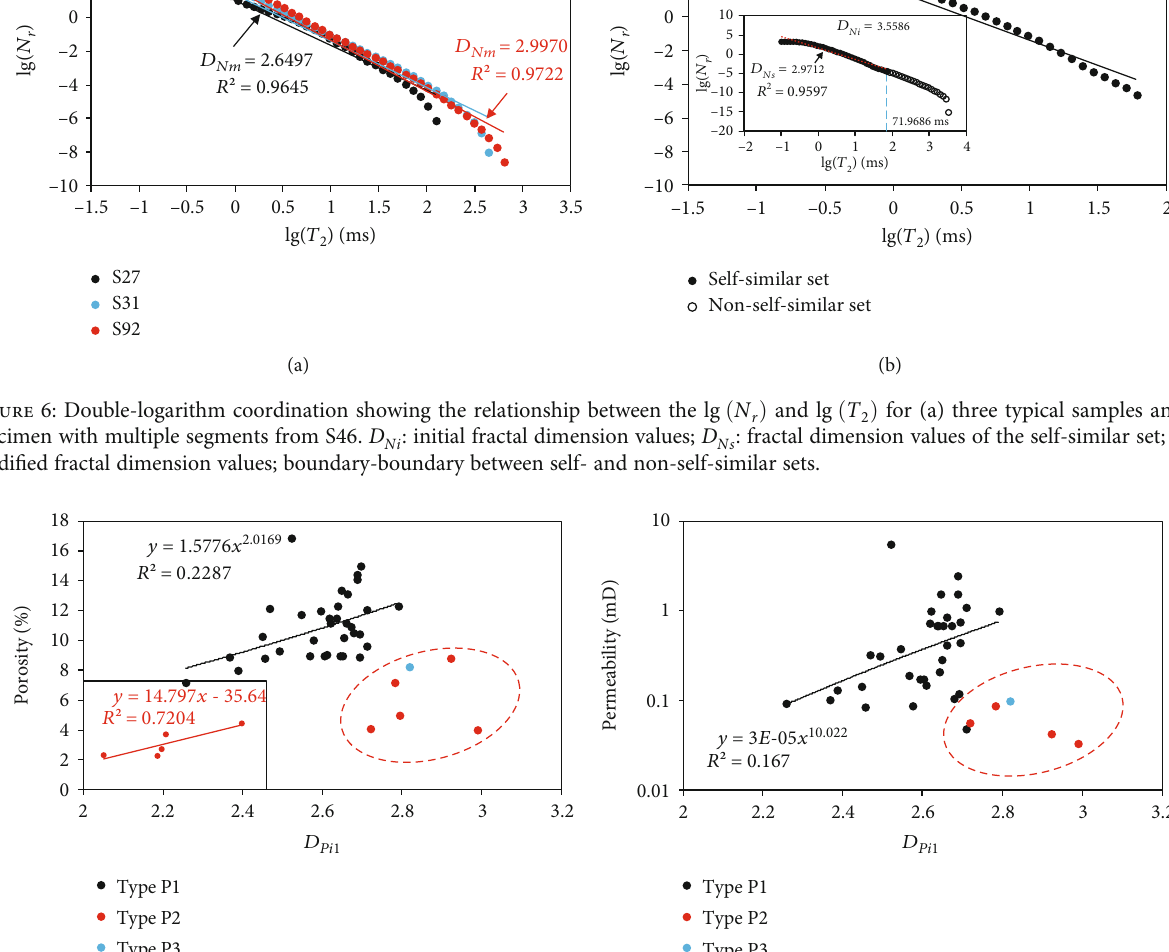
Figure 7: The cross-plots between multifractal parameters from PCMI tests and petrophysical properties: (a) the cross-plots between D and porosity (the inset plots presented the relationships between D and D Pi 1